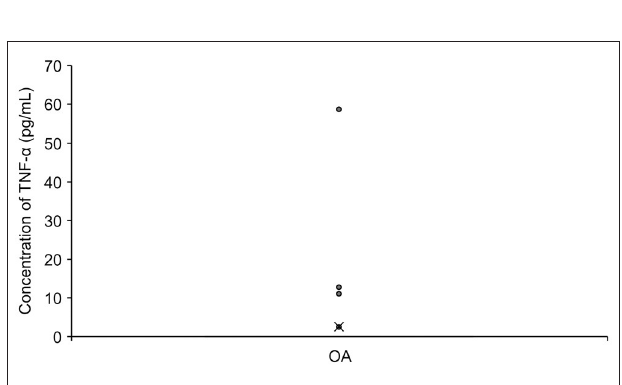
FIGURE 4 | The concentration of TNF- α in Serum in OA dogs ( n = 50). The mean value is denoted as ‘x’. OA: